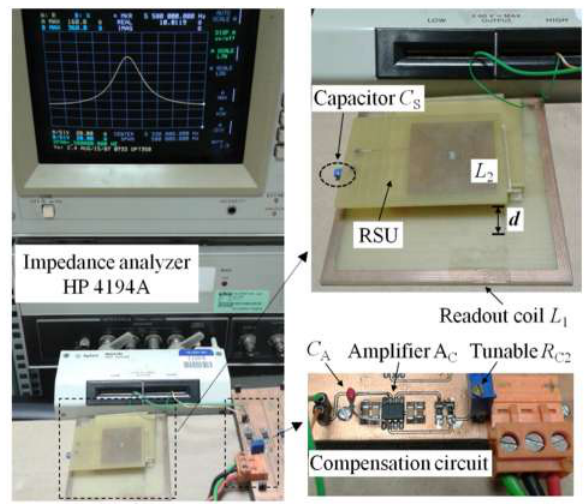
Figure 17. Experimental setup and interrogation system based on impedance-measurement technique with parasitic capacitance compensation.